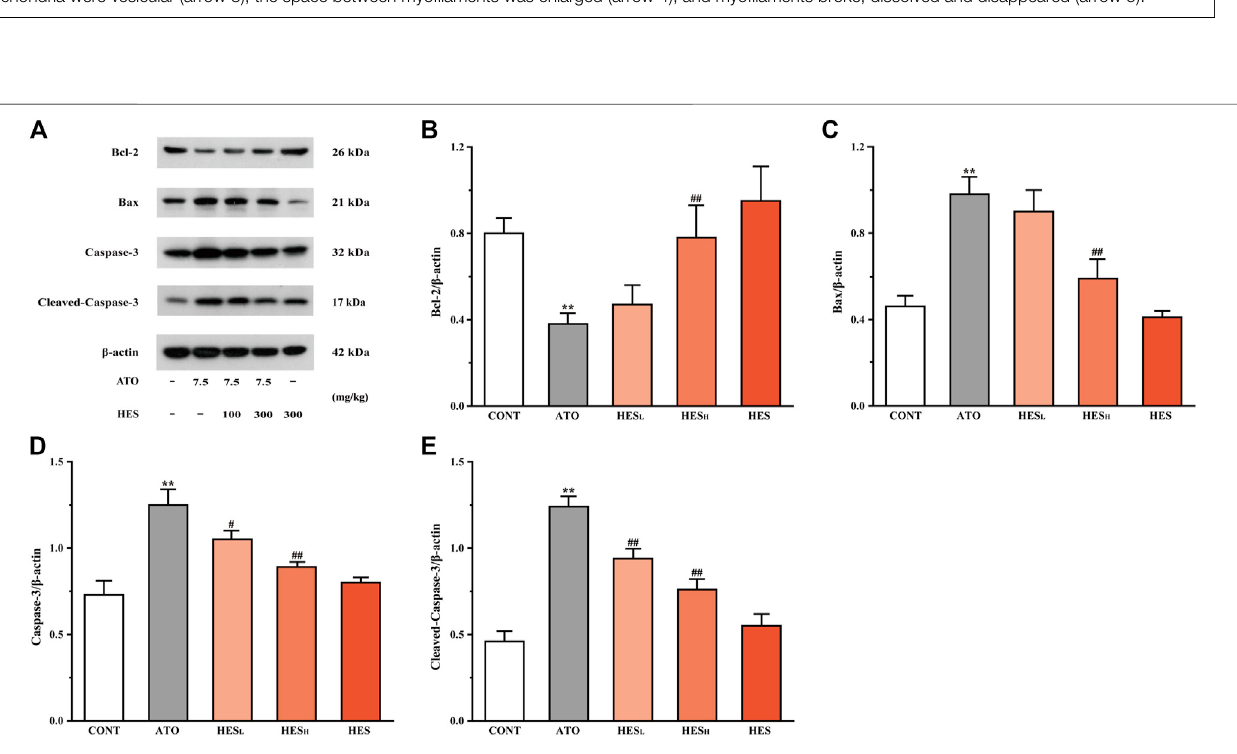
FIGURE 8 | Changes in Bcl-2, Bax, Caspase-3 and cleaved-Caspase-3 protein expressions between ATO group and HES treatment groups. Results are expressed as mean ± SD ( n (cid:1) 3). ** p < 0.01, compared to CONT group, ## p < 0.01, compared to ATO group.